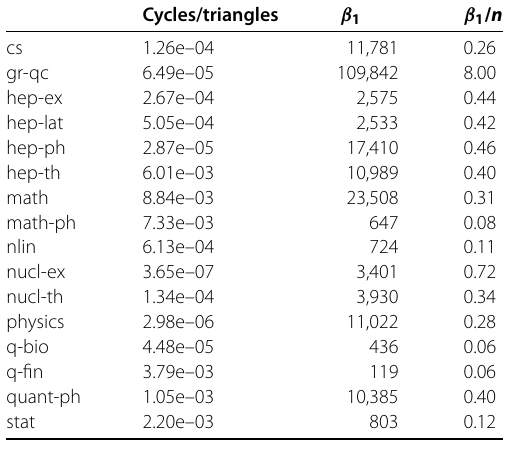
Table 3 Analytics on Homological cycles. For each category we show the number of cycles in the graph ( β 1 ), β 1 divided by n , the total number of authors in each category, and the percentage of triangles in the graph that don’t satisfy triadic closure, that is # cycles of length 3 graph. Note that by number of triangles in the graph we mean the number # triangles in the of closed paths of length three in the co-authorship network Cycles/triangles β 1 β 1 / n cs 1.26e–04 11,781